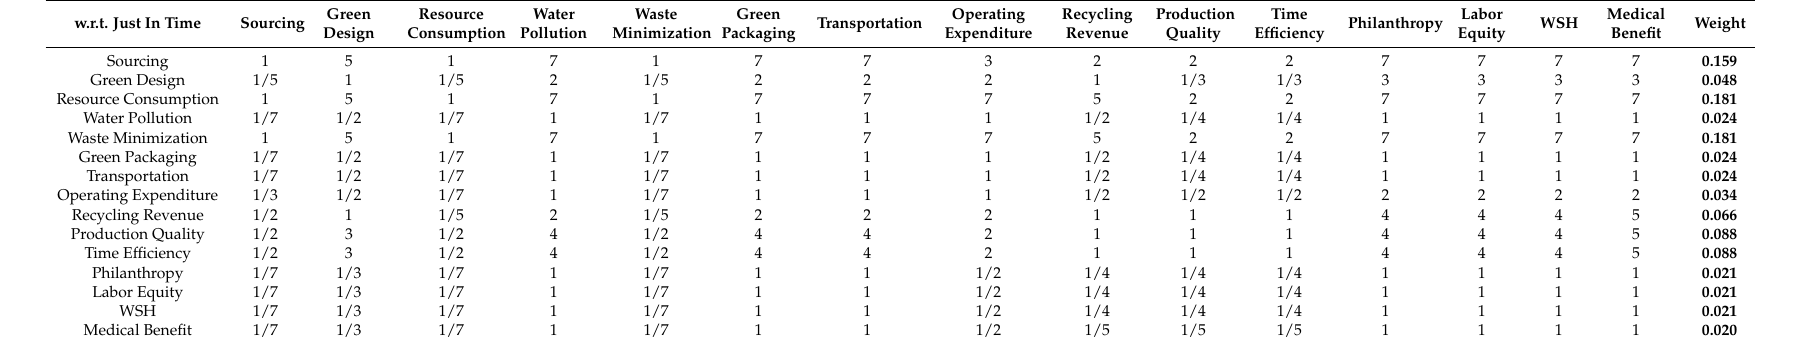
Table 11. Pairwise comparisons of the criteria w.r.t. Just in Time.